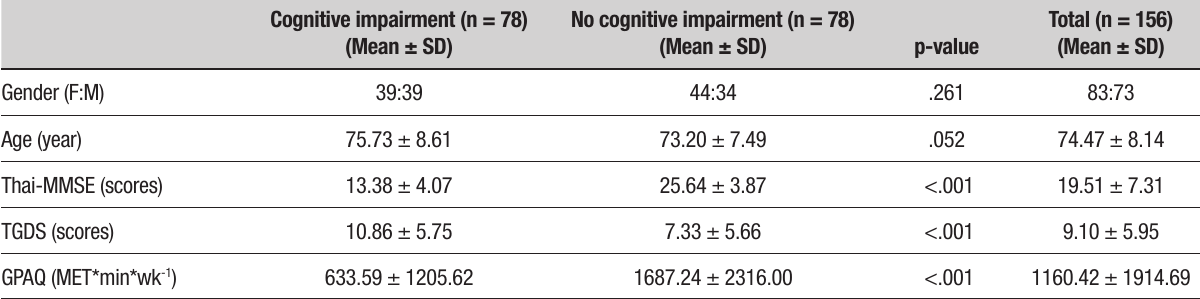
Table 1. Comparison between older adults with and without cognitive